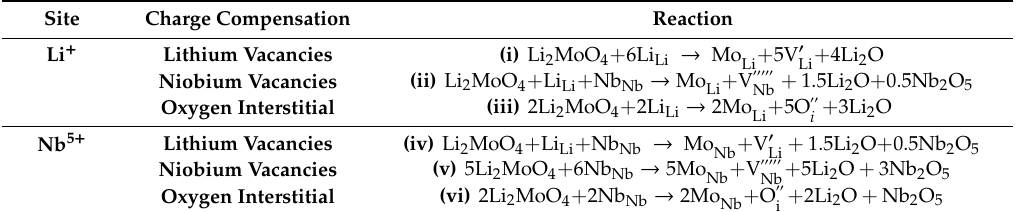
Table 10. Types of defects considered due to Mo 6+ incorporation in LiNbO 3.